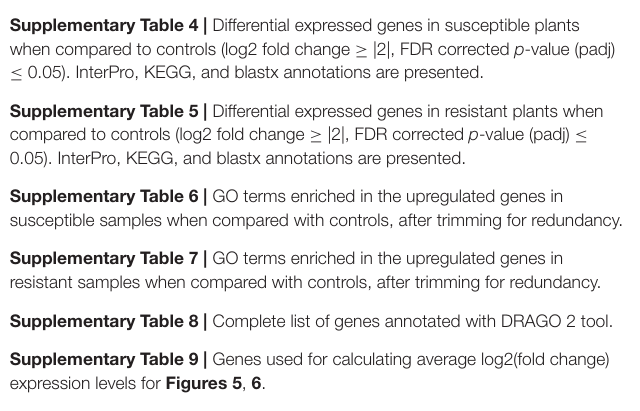
0.05). InterPro, KEGG, and blastx annotations are presented.